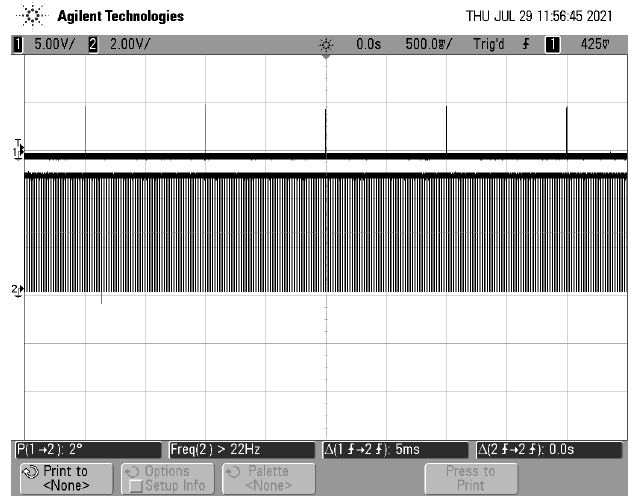
Figure 8. Schmitt -trigger output signal and PPS pulses. Five PPS pulses can be seen at the top while the total of the cycles are monitored in the signal below.